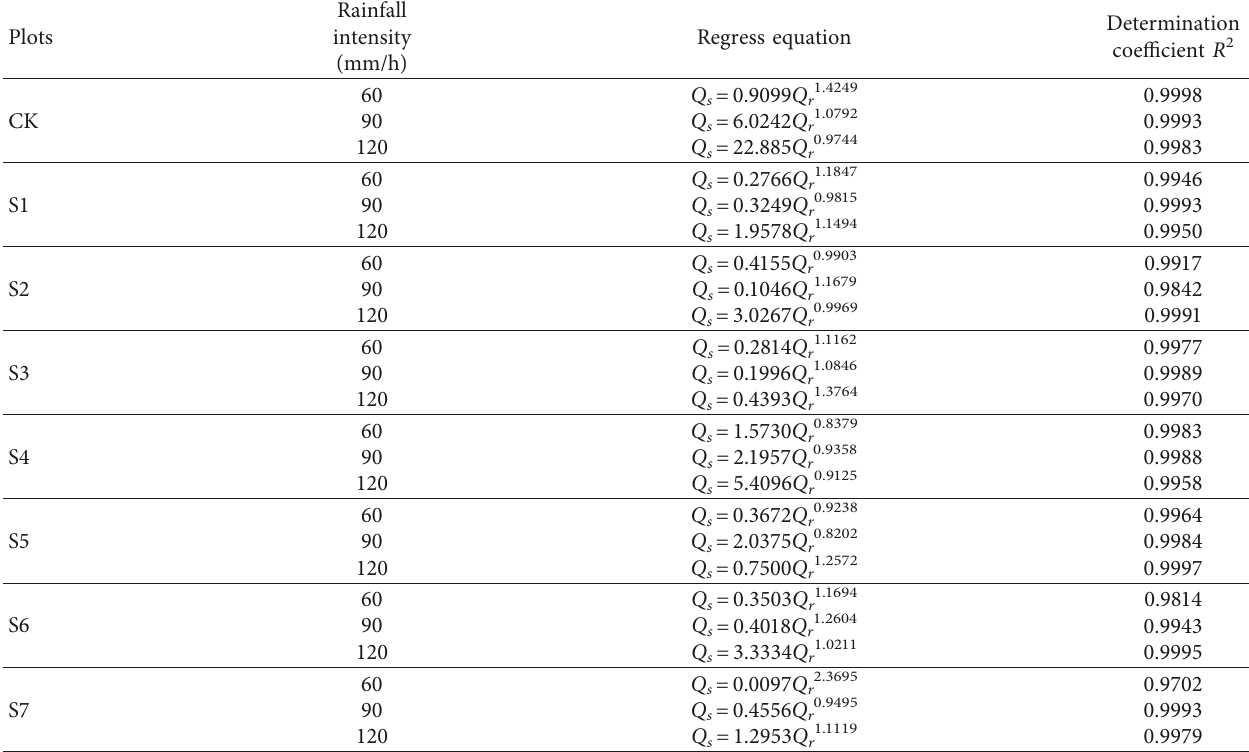
Table 3: Relationship between the accumulated runoff volume and the accumulated sediment load under different vegetation covers and rainfall